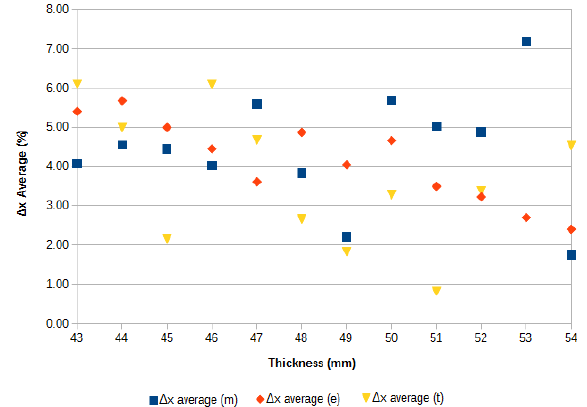
Figure 5. Graph regarding the difference between direct measurement on site by one operator, and digital measurement by three operators (m, e, t). This graph includes bricks of all stratigraphic units. Direct measurement is considered here as reference, since mensiochronology curves are usually developed based on measurements on site. Brick thickness is represented on x-axis: the range 43-54 mm is selected since it includes most measurements. The mean difference in absolute value is weighted on the brick thickness (from direct measurement on site), giving a percentage that is represented on y-axis. It is not possible to recognize a linear trend linking the difference between direct and digital measurements and brick thickness, nor considering the measurements by each operator alone working on the digital model. Further observation may be done by increasing the number of operators.